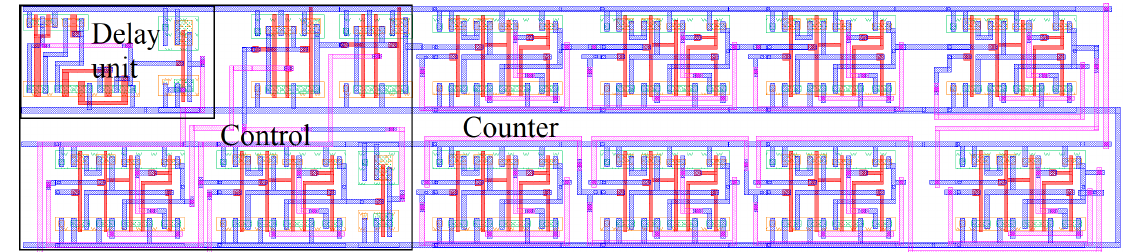
Figure 16. Microchip of the counter-based time-to-digital converter (TDC). It consists of a delay unit, a control unit, and an 8-bit